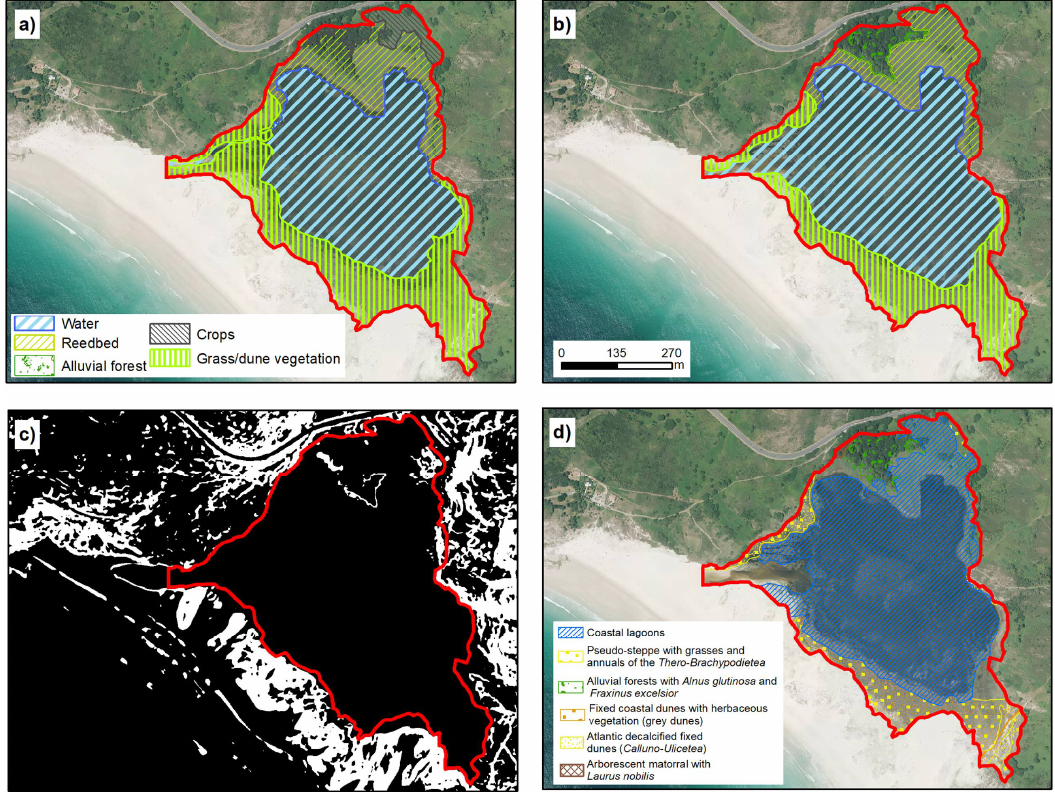
Figure 3. Coastal lagoon of Louro. ( a , b ) represent the temporal evolution of environmental units in 1989 and 2017, respectively. ( c ) shows Topographic Ruggedness Index (TRI) classification, in black, values below mean and in white the values above mean. ( d ) O ffi cial cartography representing the distribution of habitats from Annex I of Habitats Directive. The red line in all cases represent the extent marked for the lagoon by our analysis (IGN [20]; Xunta de Galicia ©